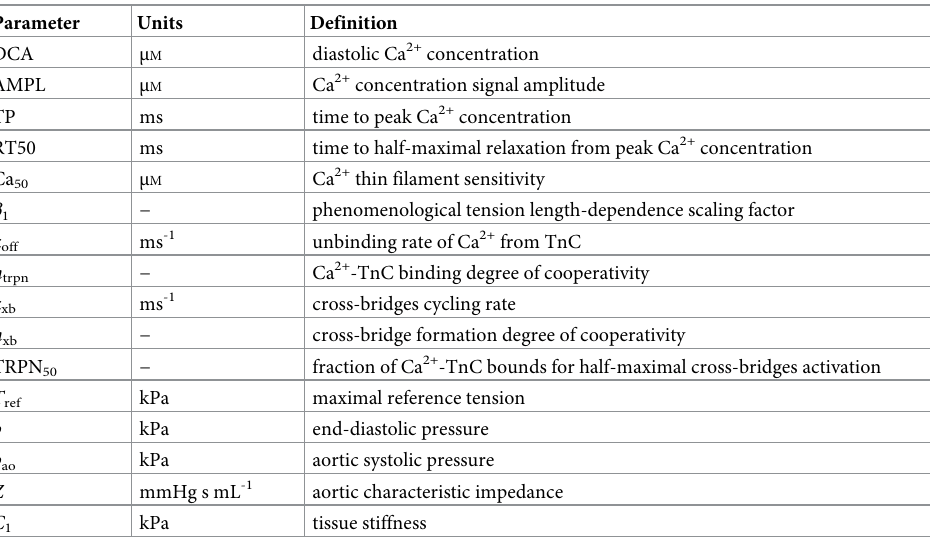
Table 1. Model input parameters.